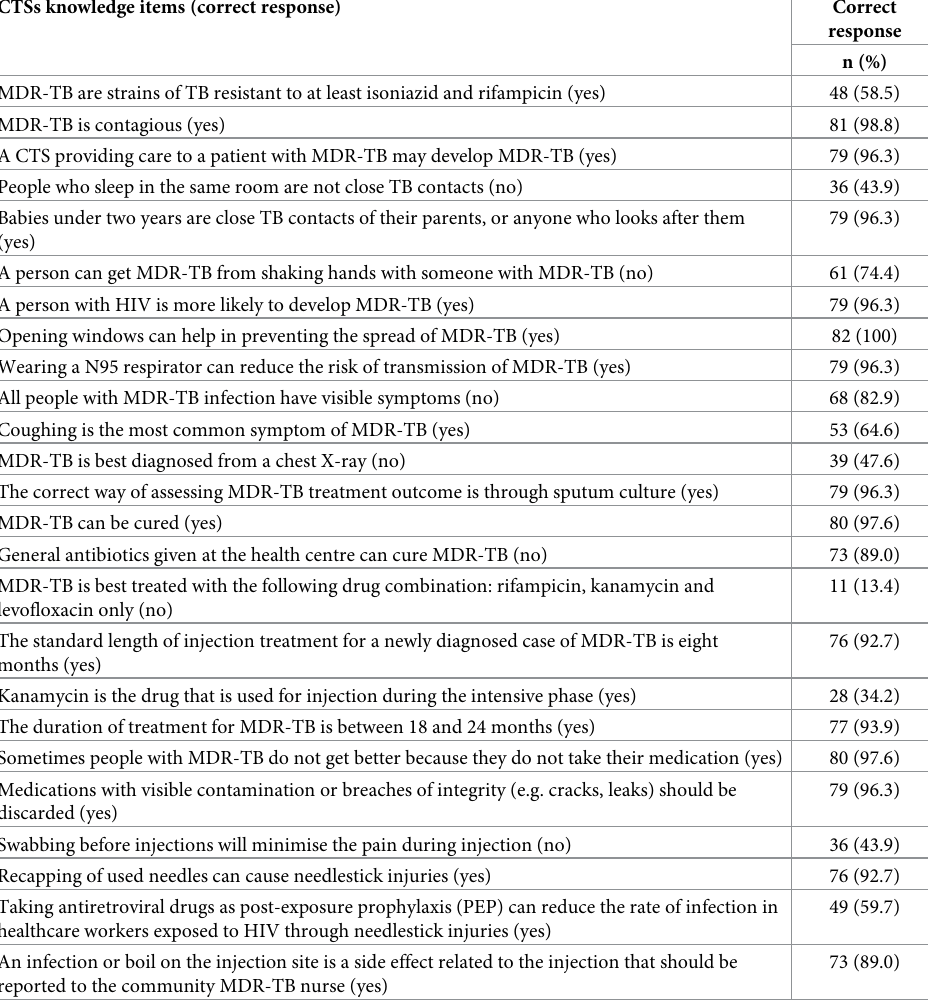
Table 2. CTSs’ knowledge about